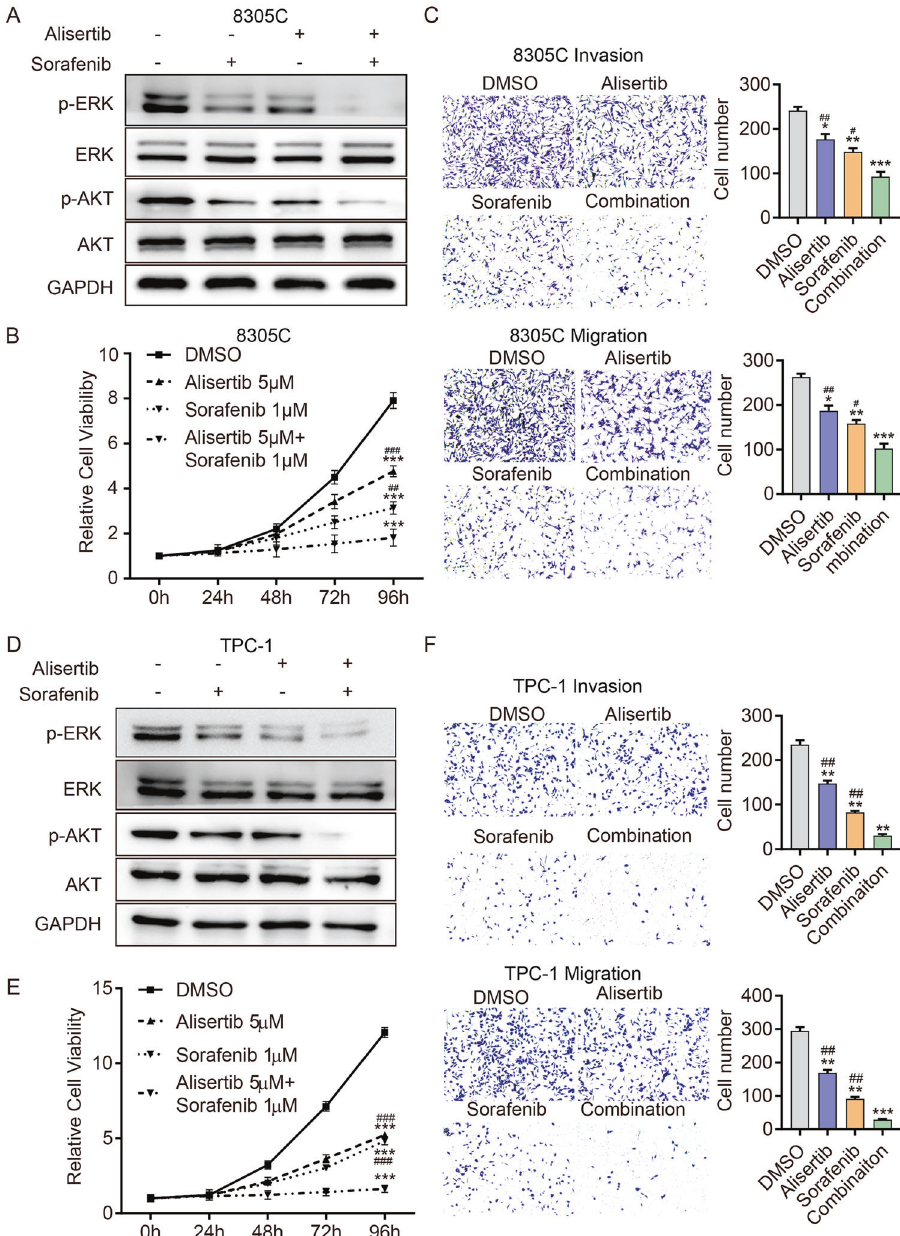
Fig. 5 Targeting Aurora-A improves the ef fi cacy of Sorafenib treatment in TC cells in vitro. A , D Western blotting detected p-ERK, ERK, p- AKT, and AKT expression in 8305 C ( A ) and TPC-1 ( D ) cells, respectively, exposed to Alisertib (5 μ mol), Sorafenib (1 μ mol) and their combination for 48 h. B , E The CCK-8 assay was performed in 8305 C ( B ) and TPC-1 ( E ) cells exposed to Alisertib (5 μ mol), Sorafenib (1 μ mol) and both drugs for 96 h. * P < 0.05, ** P < 0.01, *** P < 0.001, compared with control group. # P < 0.05, ## P < 0.01, ### P < 0.001, compared with the combination group. C , F Transwell of migration and invasion assay detected the migration and invasion ability of 8305 C ( C ) and TPC-1 ( F ) cells pretreated with Alisertib (5 μ mol), Sorafenib (1 μ mol) or both drugs for 2 days. * P < 0.05, ** P < 0.01, *** P < 0.001, compared with the control group. # P < 0.05, ## P < 0.01, ### P < 0.001, compared with the combination group. The data are presented as the mean ± SD of three independent